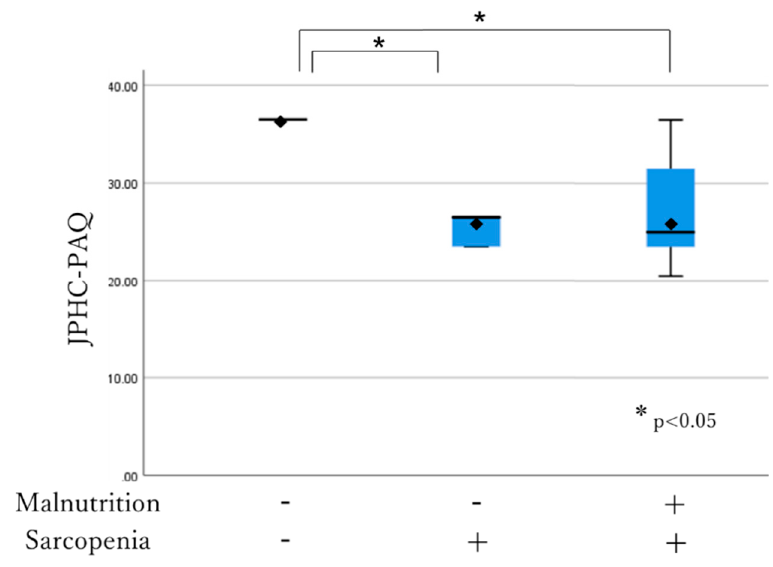
Figure 3. Subgroup association with JPHC-PACQ score.